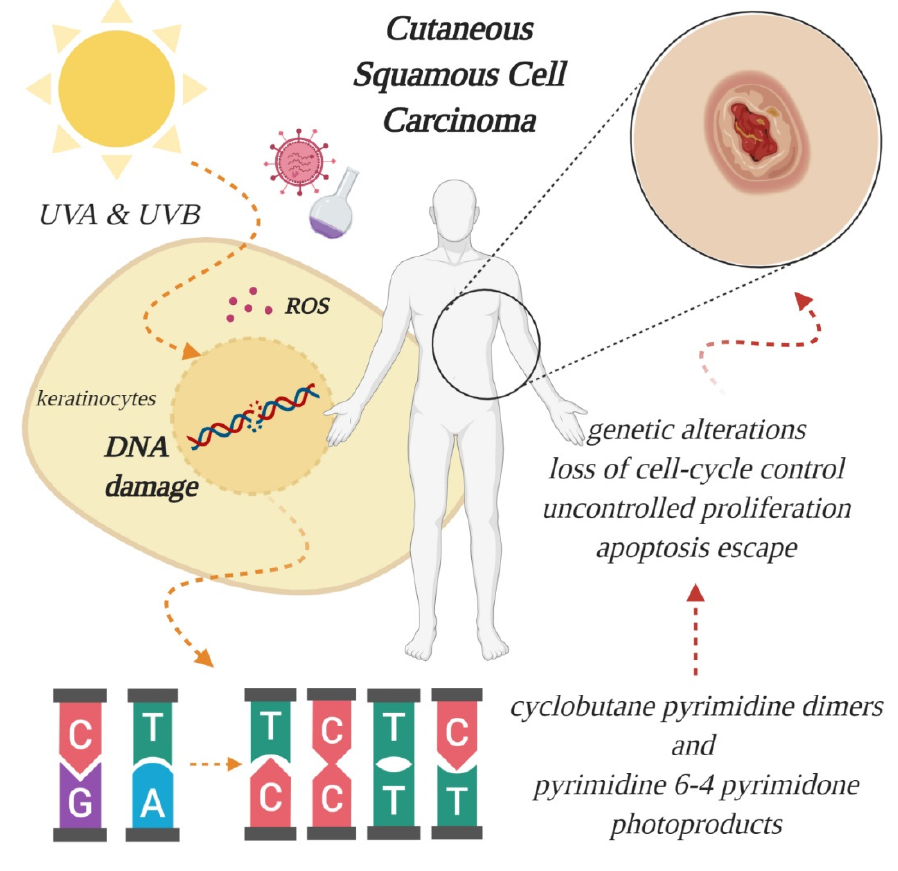
Figure 1. Effect of ultraviolet radiation on the genetic material of epidermal keratinocytes, from which cutaneous squamous cell carcinoma (SCC) originates. Excessive absorption of ultraviolet (UV) light generates oxidative stress, through formation of reactive oxygen species (ROS), and breaks the double helix, leading to aberrant binding of pyrimidines and further genetic alterations, culminating with tumor formation. Other risk factors include viral infections and chemical exposure (created in BioRender.com).